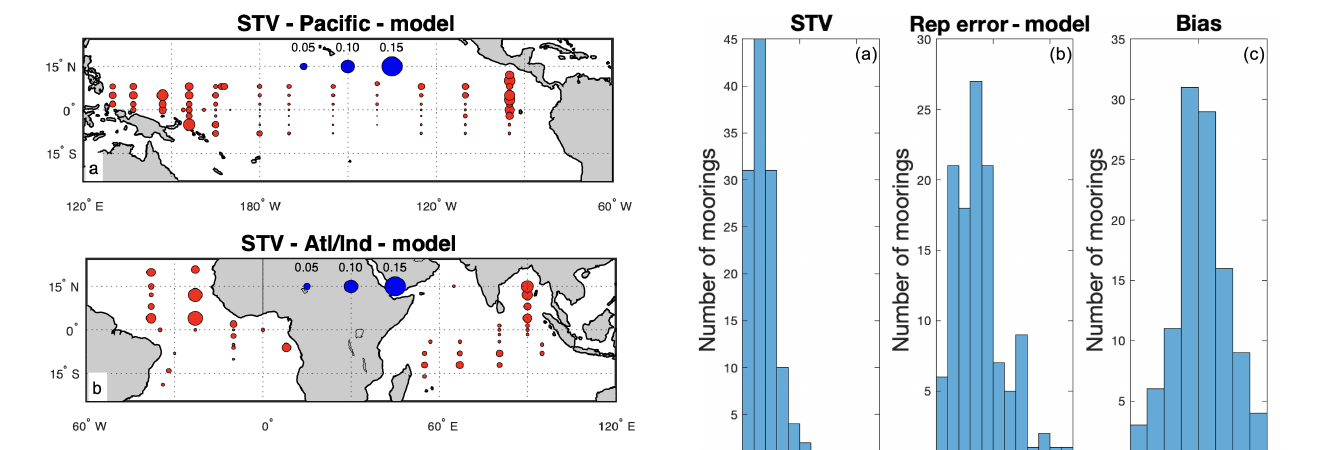
Figure 8. The same as Fig. 4 but for STV computed from the MIT- gcm. Panel (a) shows the Pacific Basin, and panel (b) shows the Atlantic and Indian basins. Table 1. Median values for all of the moorings and mooring loca- tions from the distributions of Figs. 5 and 9.